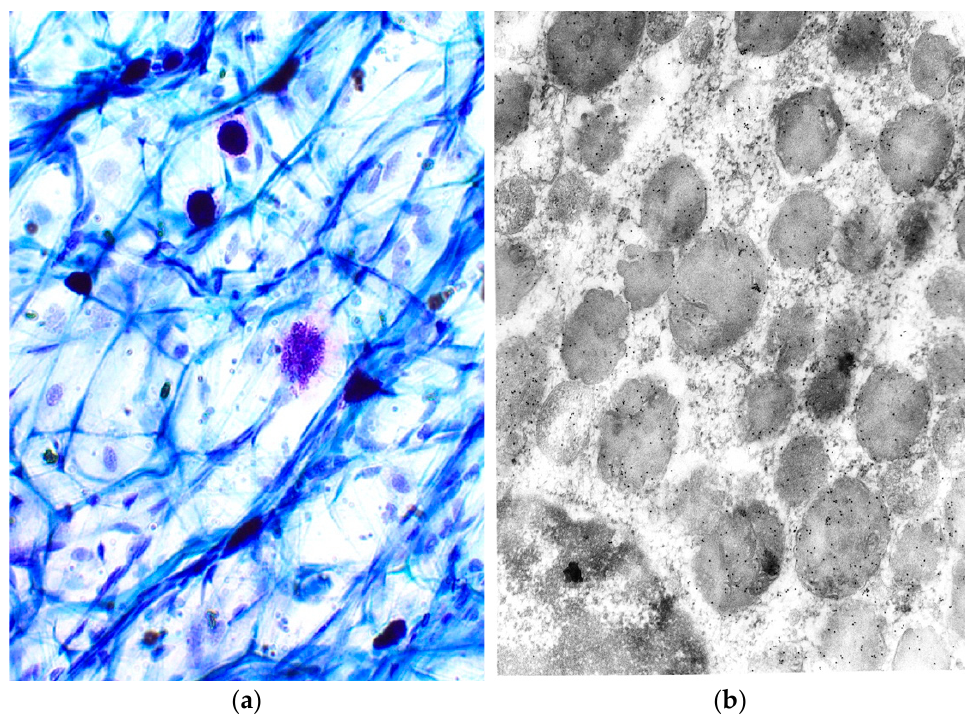
Figure 1. ( a ) Metachromatic properties of MC granules. Light microscopy, Toluidin blue, magnification × 40; ( b ) localization of tryptase in MC granules. Electron microscopy, magnification × 2500.